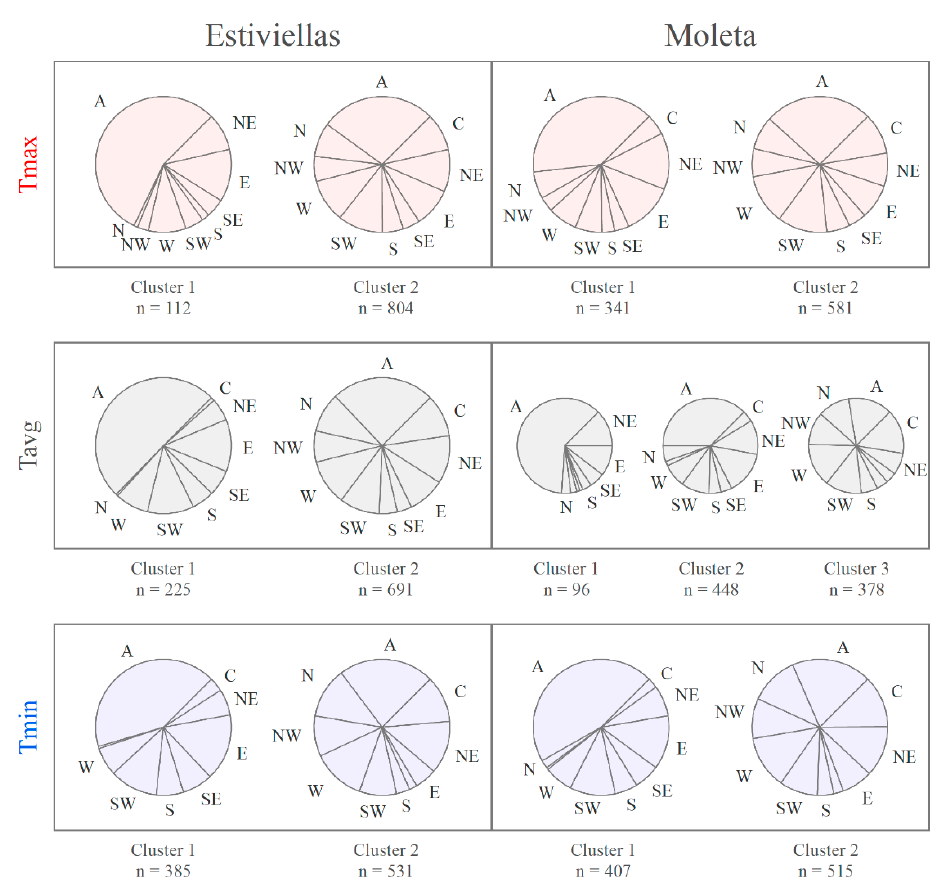
Figure 9. Circulation weather type (CWT) frequency for the Tmax , Tmin and Tavg clusters. n indicates the number of days in each cluster. The unclassifiable (U) type was not computed.